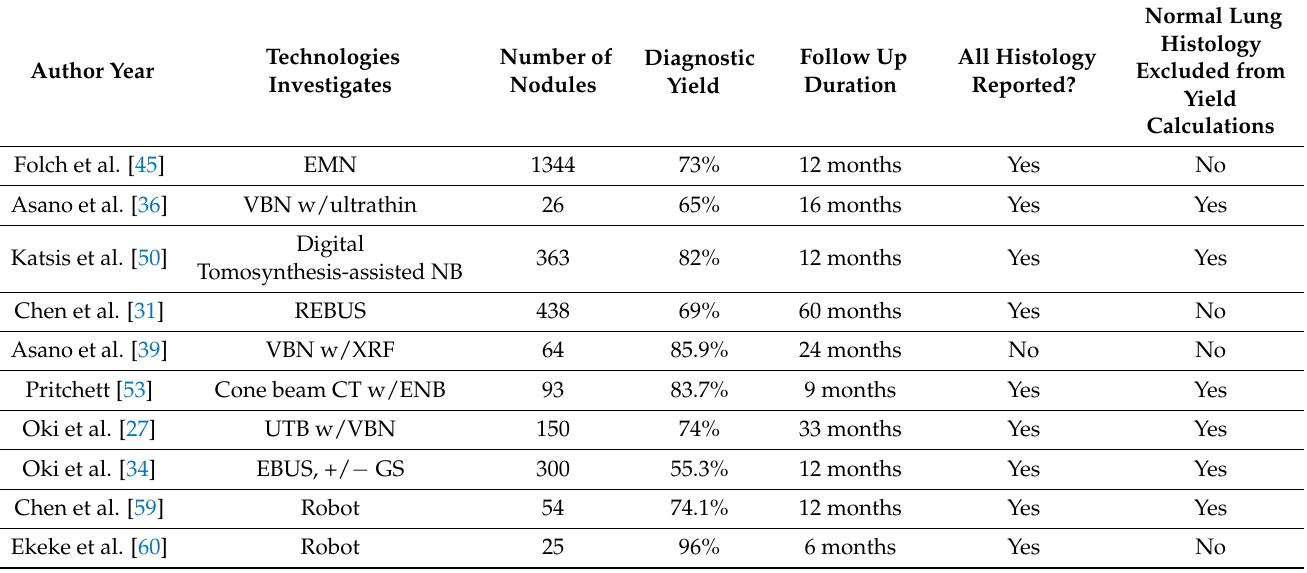
Table 1. A list of studies examining the diagnostic yield of various bronchoscopic techniques for the diagnosis of lung nodules. Note the heterogeneity in defining adequate follow up duration and what is considered diagnostic histology.